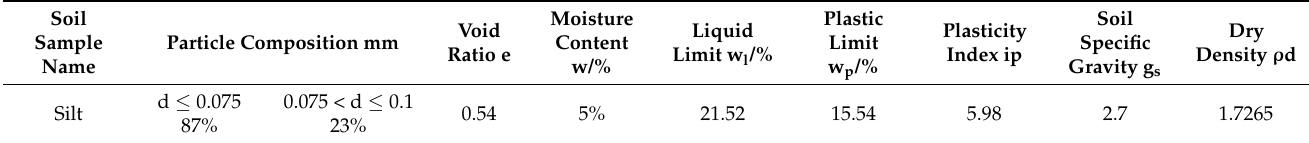
Table 1. Basic physical parameters of